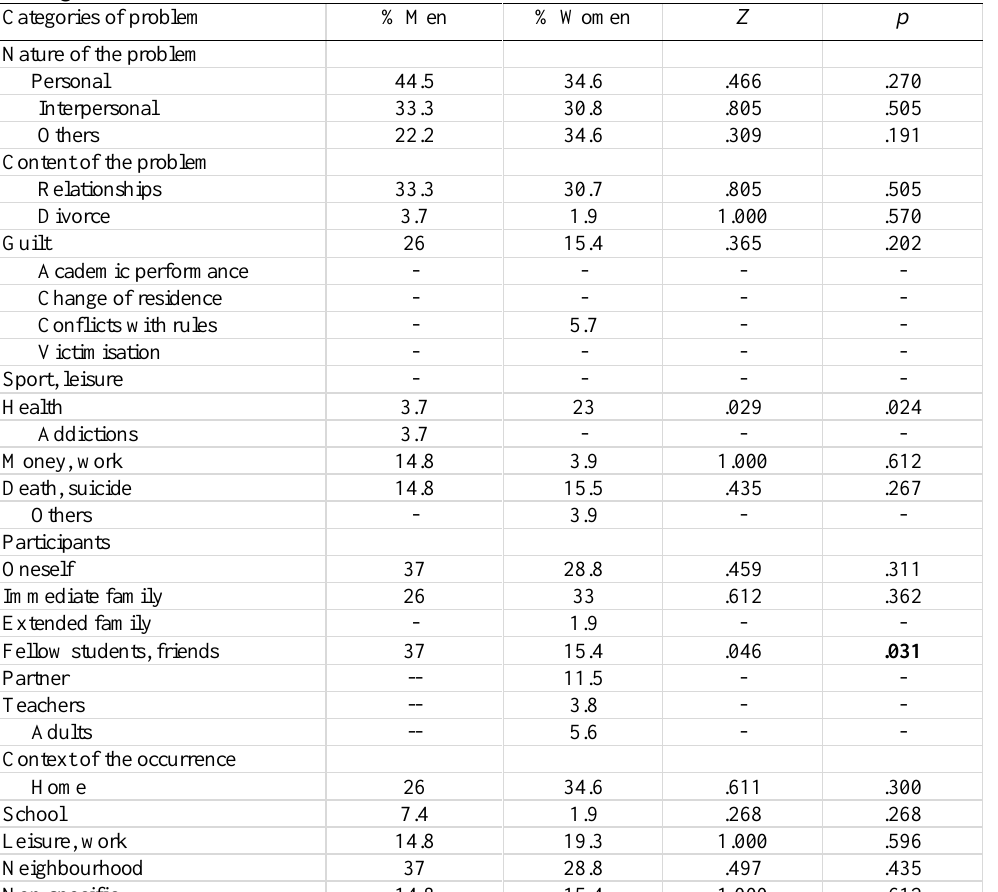
Classification of problems into categories (CRI-A). Percentages and significance by